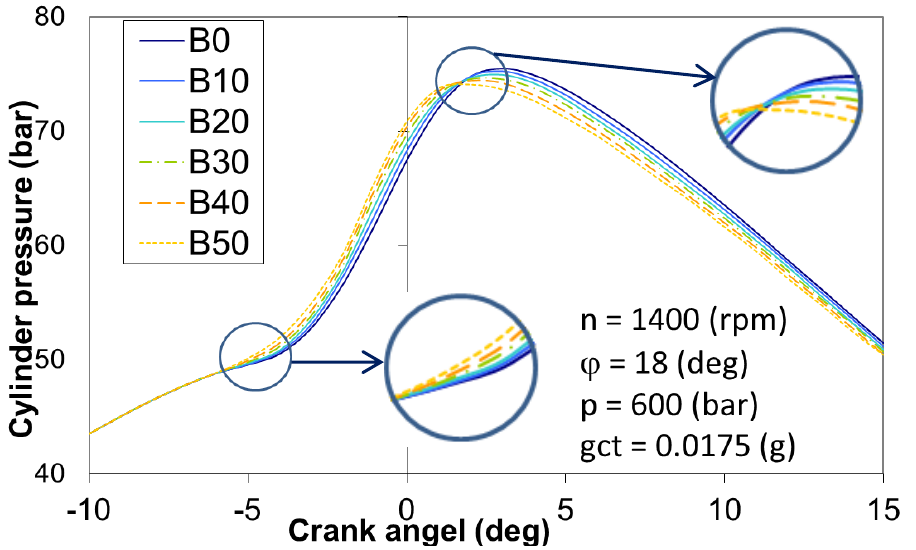
Figure 6. Evolution of cylinder pressure of fuel B0, B10, B20, B30, B40, and B50. Table 9. Comparisons parameters of combustion process 6 type of